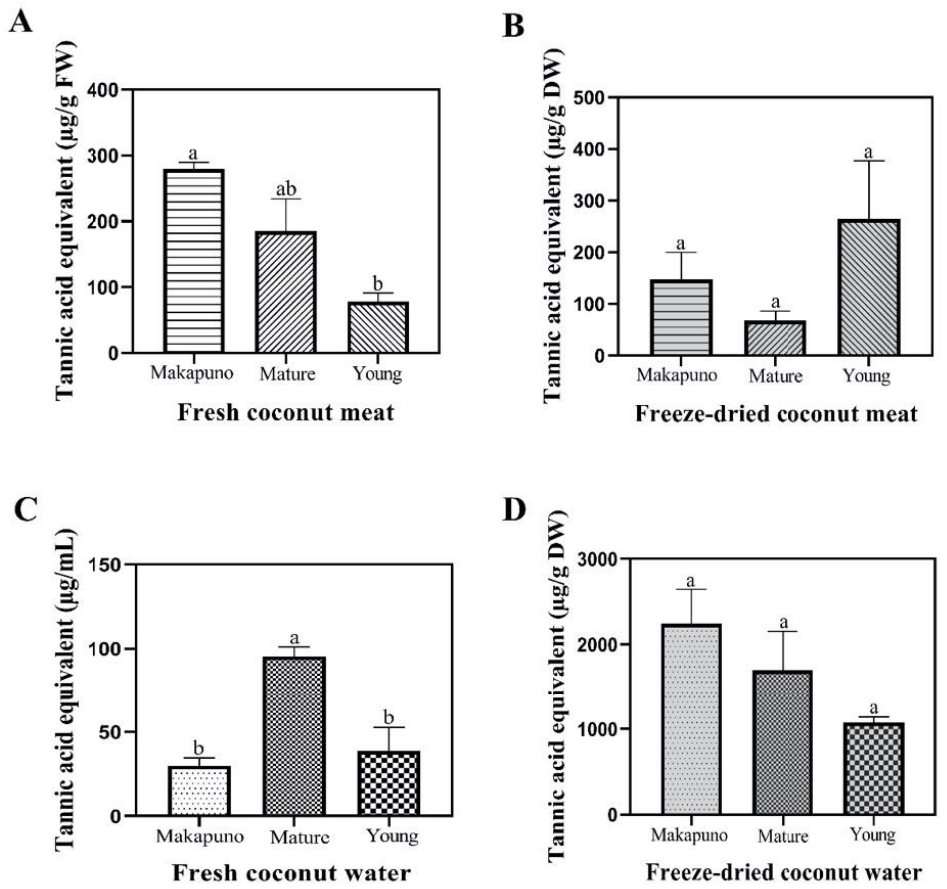
Figure 4. Tannin contents of different coconut extracts. ( A ) Fresh coconut meat sample ( B ) Freeze- dried coconut meat sample ( C ) Fresh coconut water sample ( D ) Freeze-dried coconut water sample. All experiments were performed in triplicate. Data are expressed as mean ± SE (n = 3, p < 0.05) for all tested. Different letters indicate mean values significantly